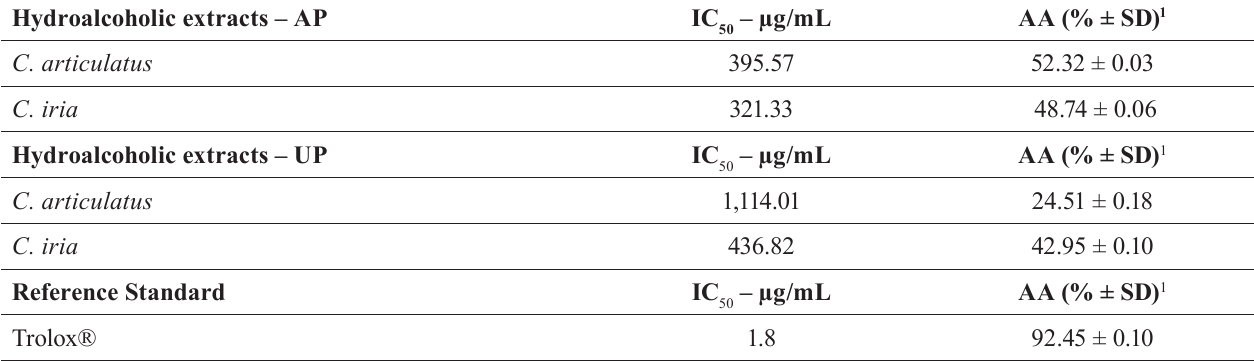
TABLE II - In vitro antioxidant activity of the hydroalcoholic extracts of Cyperus articulatus L. and Cyperus iria L. Hydroalcoholic extracts –